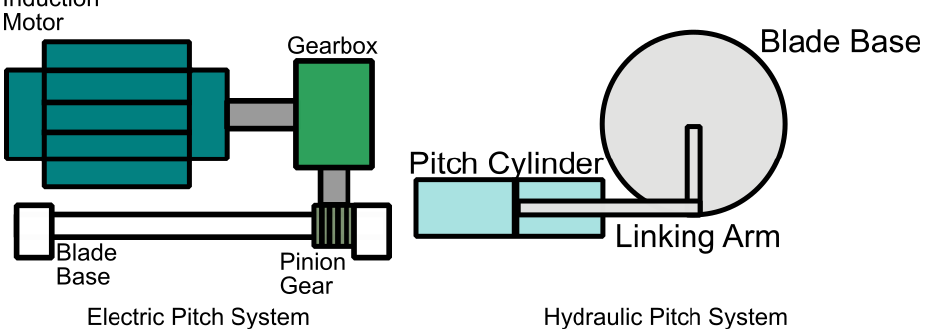
Figure 1. Schematic of Wind Turbine Pitch Systems ( Left ) Schematic of an electric pitch system ( Right ) Schematic of a hydraulic pitch